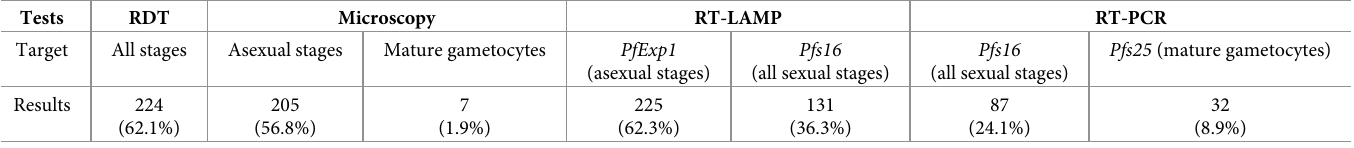
Table 2. Prevalence of P . falciparum infection and gametocyte